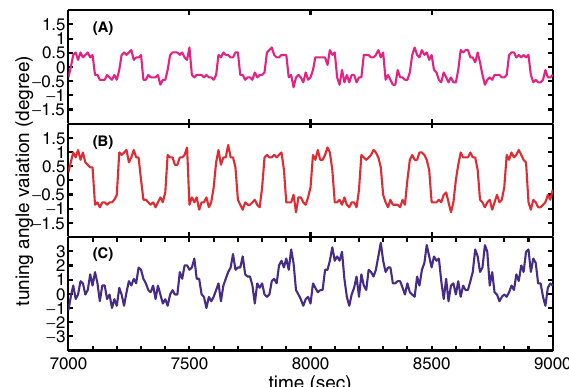
FIG. 6. (Color) (a),(b) show the rf tuning angles for cavities 1 and 2 adjusted by the low-level rf-feedback system. (c) shows the tuning angle derived from the observed horizontal